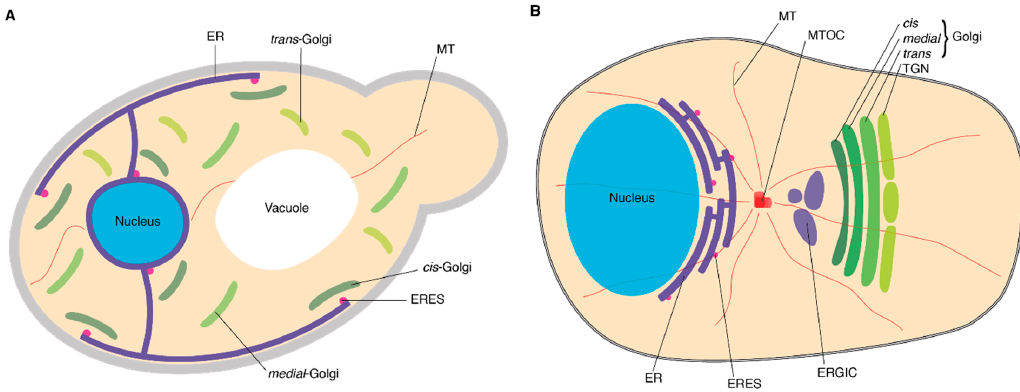
Figure 1. Schematic overview of the early secretory pathway in Saccharomyces cerevisiae ( A ) and mammalian cells ( B ). Abbreviations: ER, endoplasmic reticulum; ERES, endoplasmic reticulum exit sites; ERGIC, endoplasmic reticulum-Golgi intermediate compartment; MT, microtubule; MTOC, microtubule organizing center; TGN, trans -Golgi network.